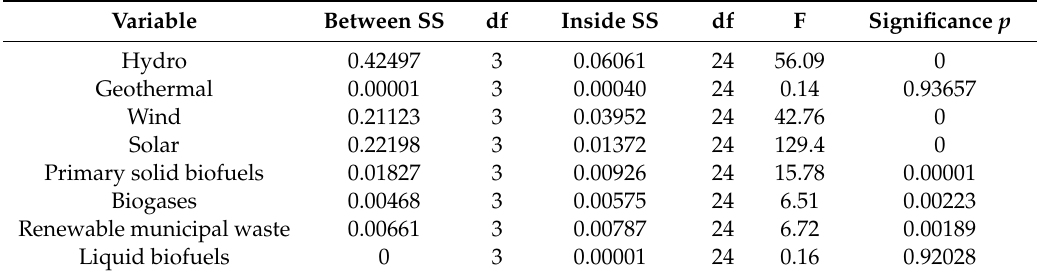
Table 23. Analysis of variance for renewable energy production (own